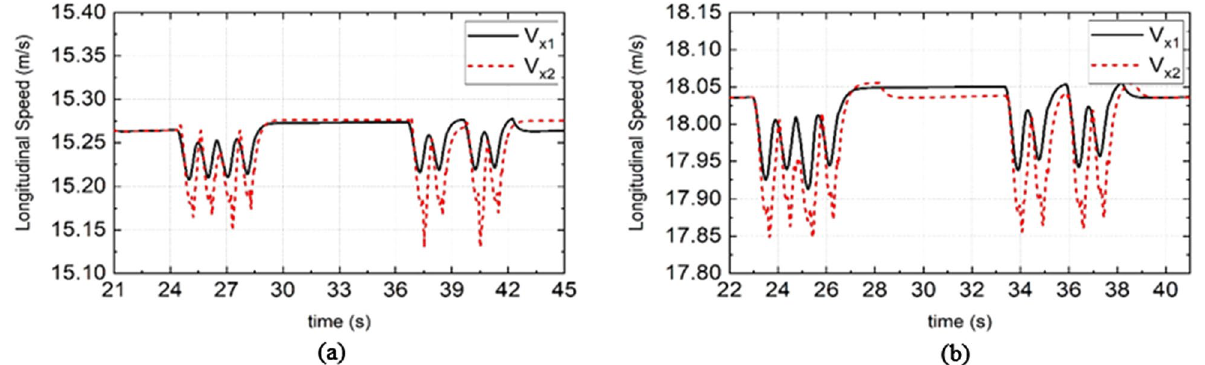
Figure 9. Simulation results of longitudinal speed under different road adhesion coefficient and different vehicle speed. ( a ) Is the simulation results of DDAV running at 55 km/h on wet road, ( b ) is the simulation results of DDAV running at 65 km/h on wet road.